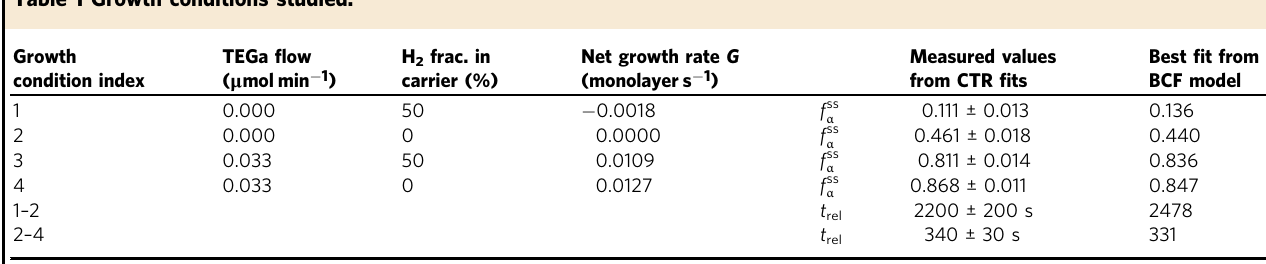
Table 1 Growth conditions